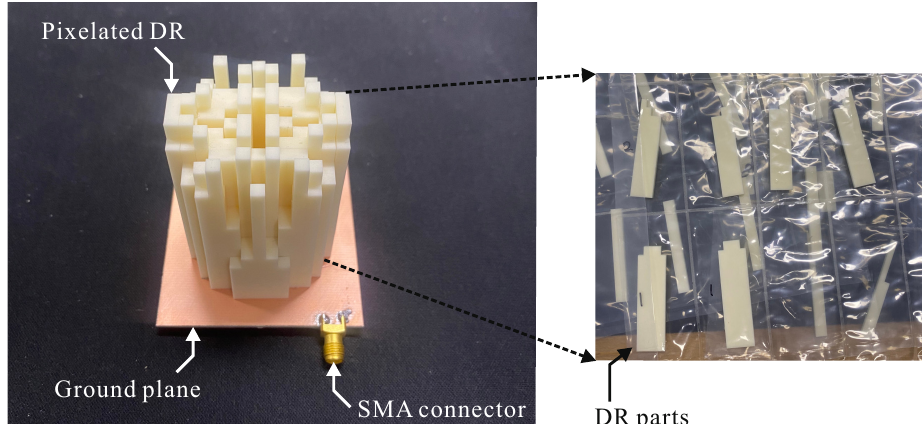
Figure 7. A photograph of the fabricated antenna and DR parts.